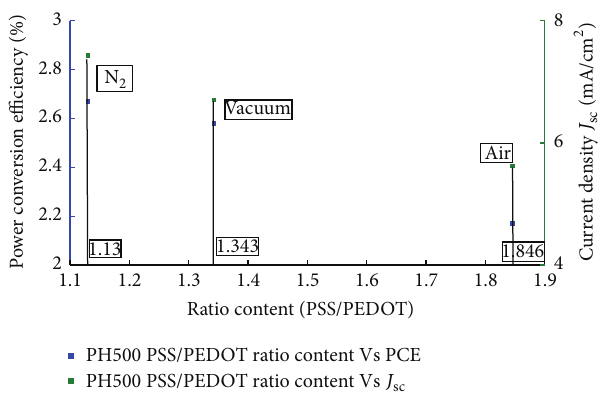
Figure 3: Plot showing the variation between the ratio of PSS to PEDOT content (obtained from XPS analysis) in PH500 measured at optimum annealing temperature in different atmospheres with the PCE and 𝐽 sc values of the OPV devices based on